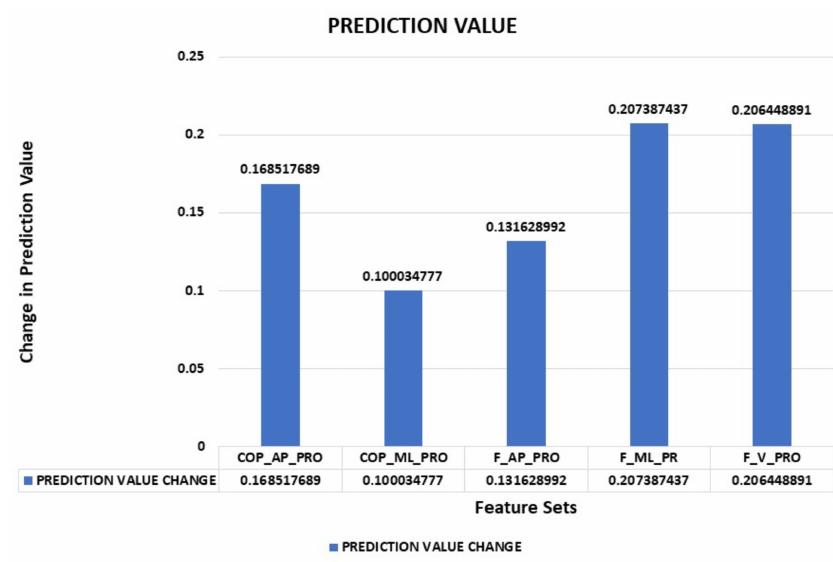
Figure 16. Prediction Value Change for 5 bilateral feature